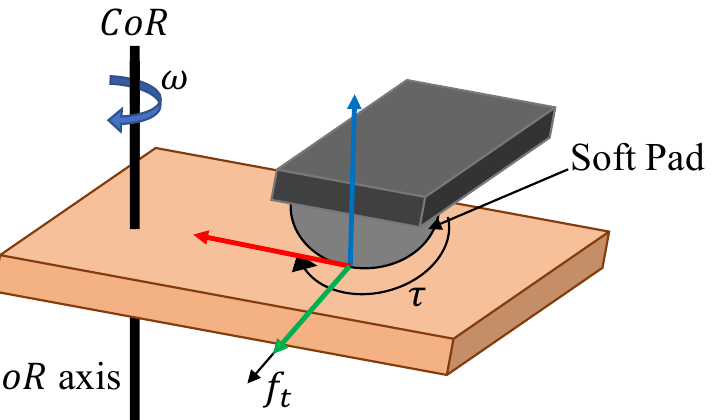
Figure 1. Planar slider and the fingertip that exchanges force and torque with it. The CoR axis is